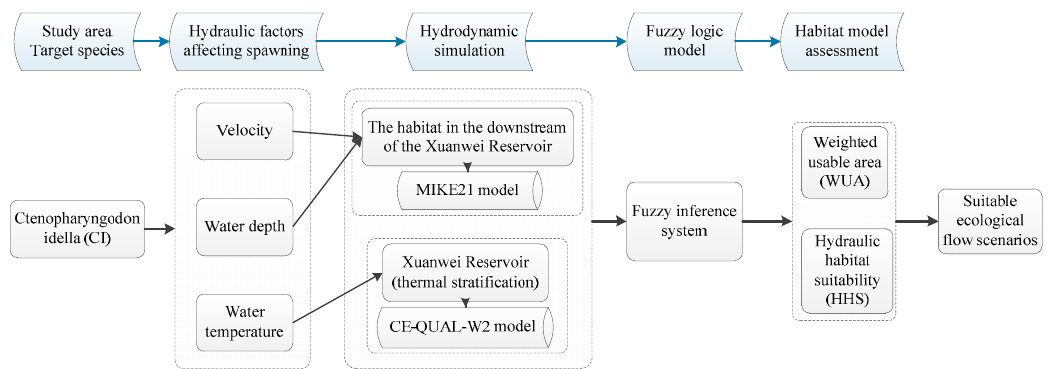
Figure 3. A graph of habitat model framework.